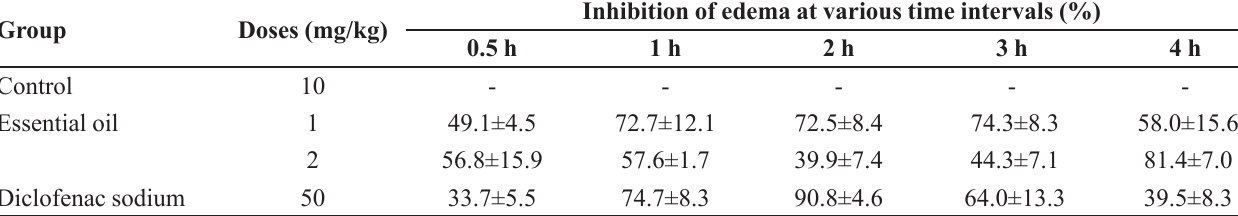
Each value represents the mean ± .E.M. of five